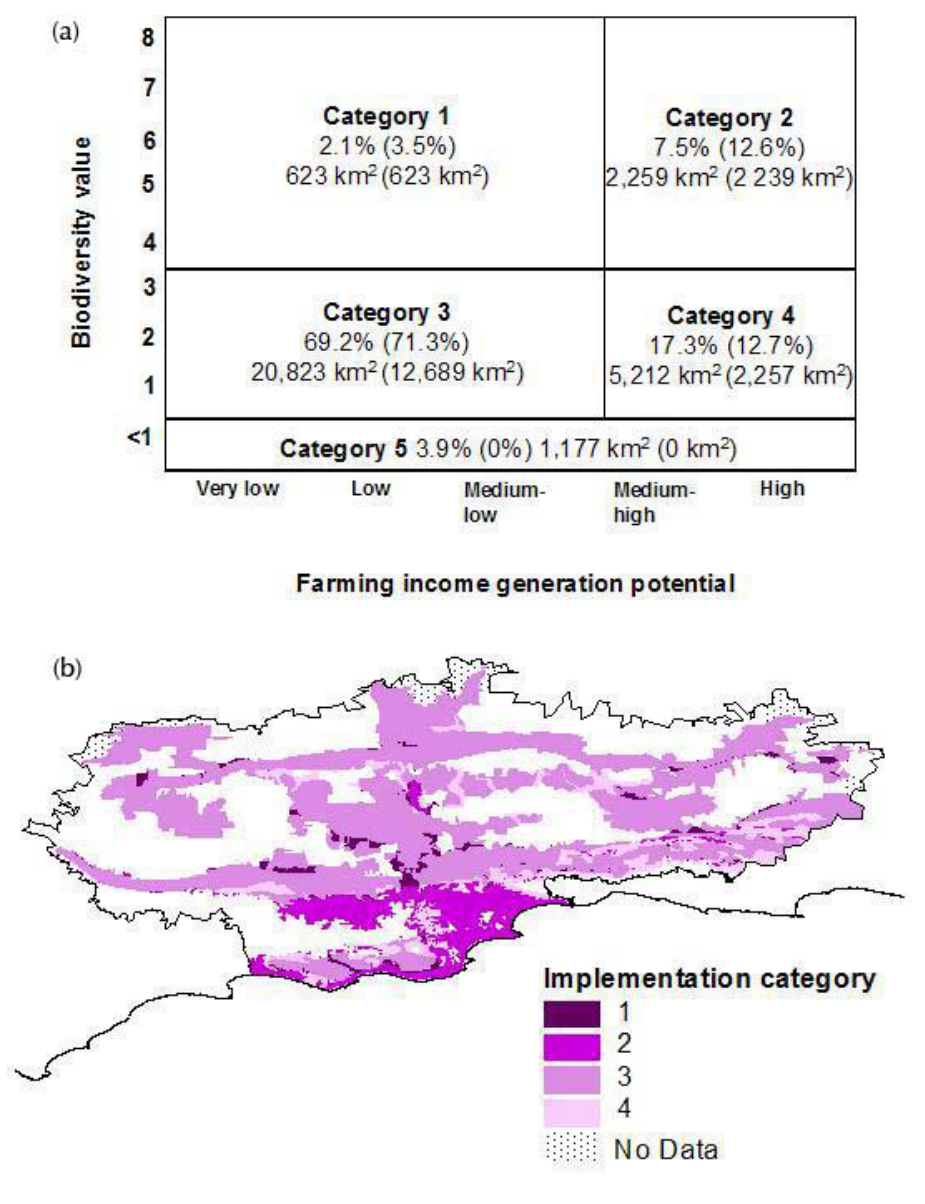
Fig. 7. The allocation of planning units to five implementation categories (a). The Y-axis is the biodiversity value of the planning unit, and incorporates a pattern and a process component, i.e. biodiversity value = ecosystem status value (from Fig. 3) + number of corridors (from Fig. 4). Both values range from 0-4 therefore the maximum value is 8, and processes and patterns contribute equally. The X-axis gives the potential farming income from Fig. 6. Individual planning units are not shown on the graph, but their areas within the entire planning domain have been summed. Sums in parentheses reflect areas inside the corridor network only. The distribution of implementation categories within the corridor network is shown in (b). Note that category 5 does not occur within the corridor network at